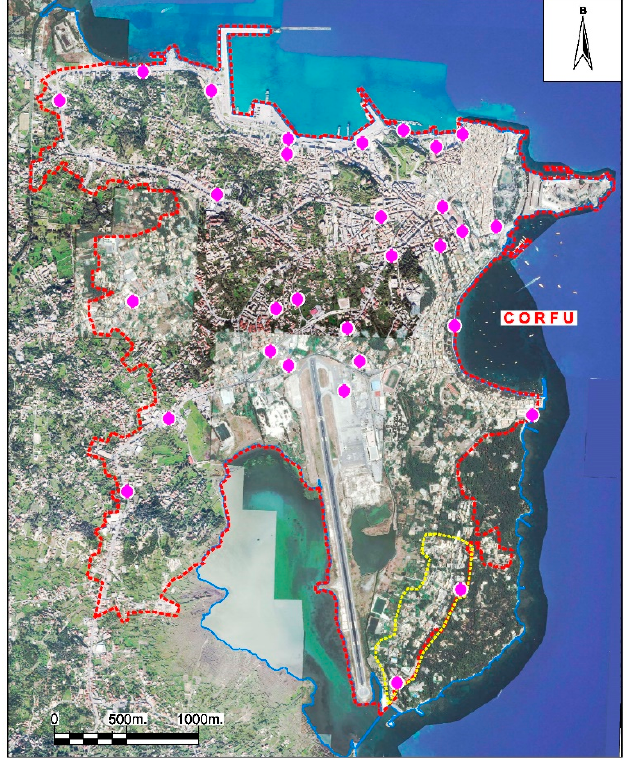
Figure 3. Geographical limits of the study subarea—Agglomeration of Corfu (red dotted line)—Study area of Kanoni (yellow dotted line)—Positions of measurements for road traffic and aircraft noise (magenta).